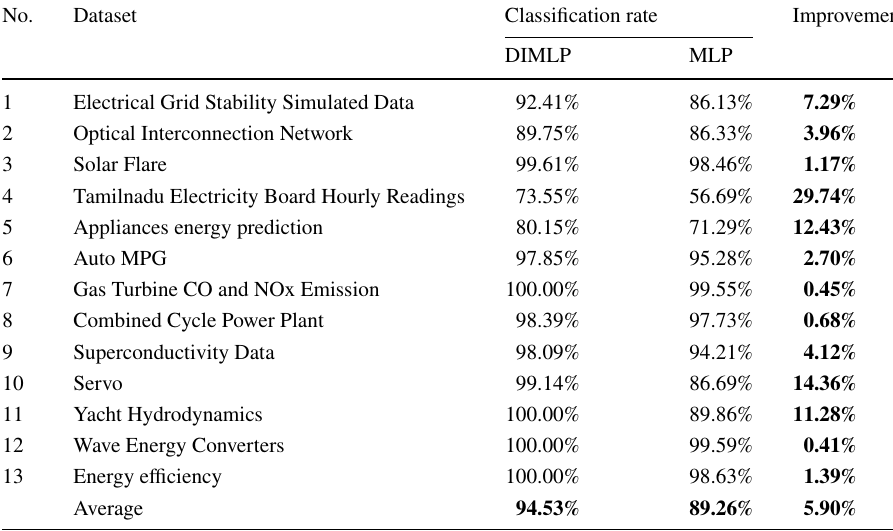
of the presented DIMLP and conventional MLP classifiers for all datasets